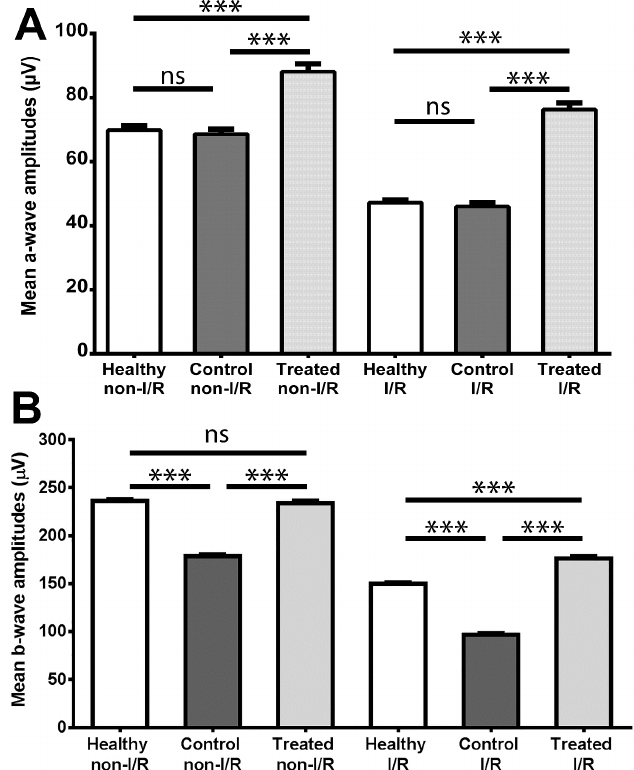
Figure 2. Electroretinographical results. ( A ) Mean a-wave amplitudes; ( B ) Mean b-wave amplitudes; Mean retinal a- and b-wave amplitudes elicited by light flashes were measured both in non-ischemic/reperfused (non-I/R) and in ischemic-reperfused eyes (I/R) of the different groups. Values are mean ± SEM in micro-Volts ( µ V). ns = no significant difference; *** p < 0.001.